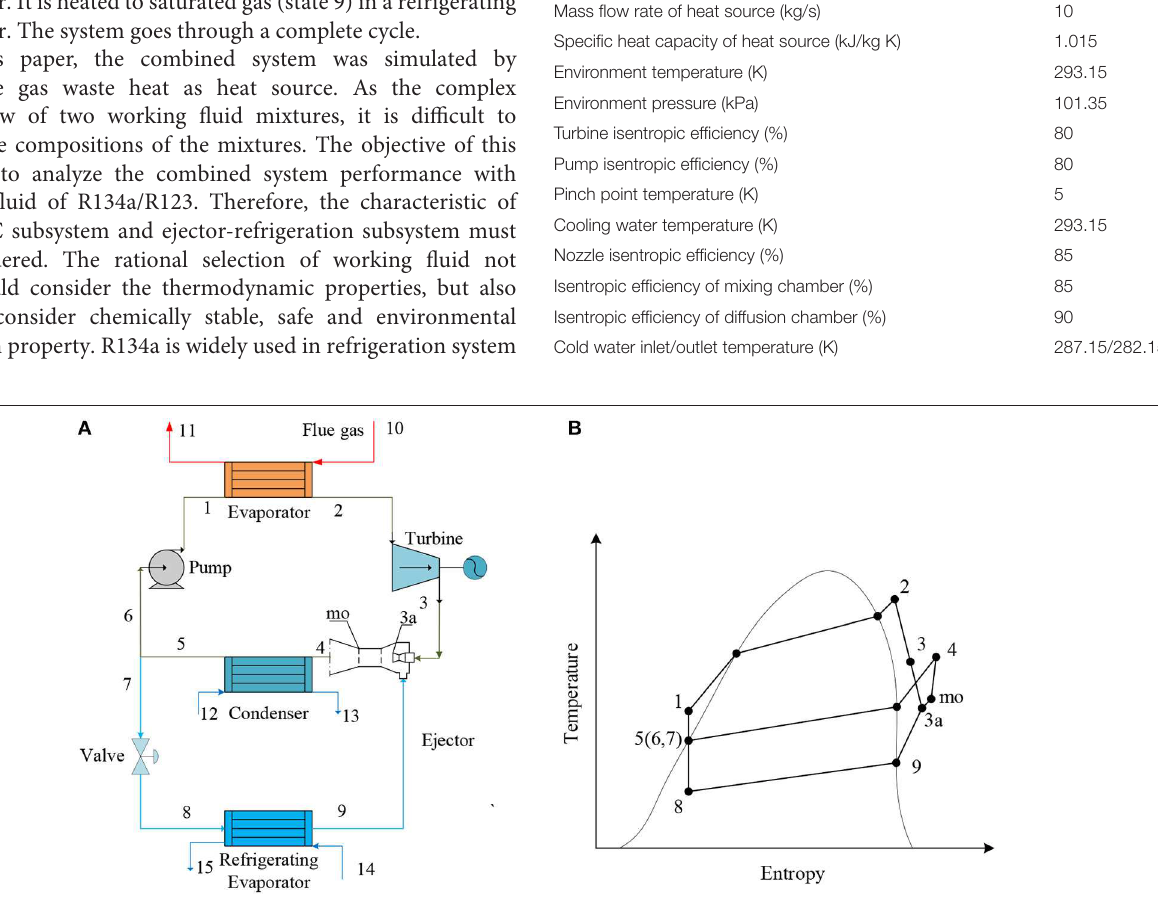
Frontiers in Energy Research |